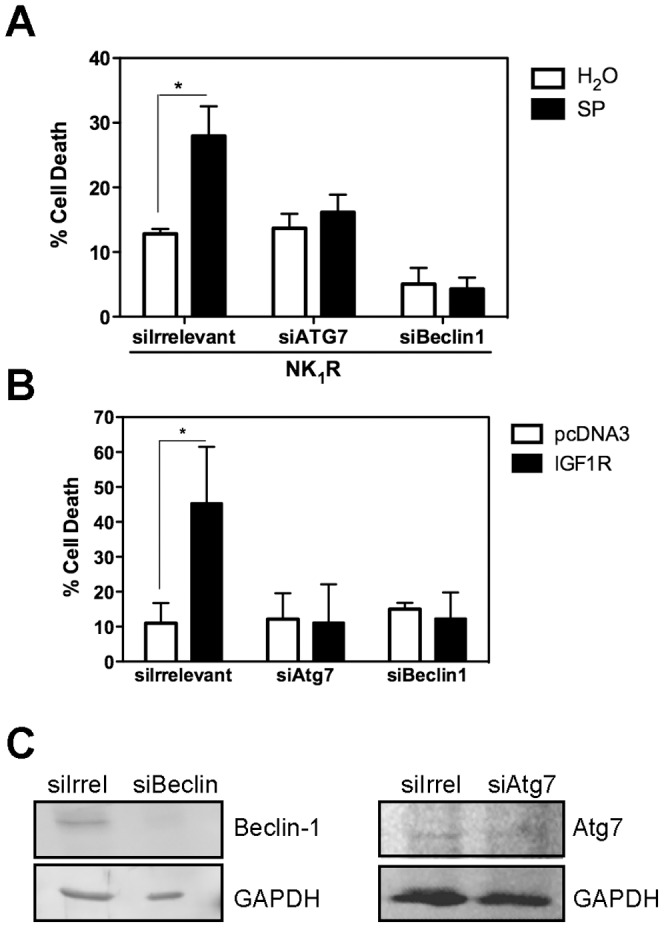
Beclin 1 and Atg7 are necessary for NR4A1-mediated vesicular cell death.
A, HEK293 cells were transfected with NK1R and exposed or not to SP, or B, with the empty vector pcDNA3 or IGF1R. Expression of Beclin 1 or Atg7 was blocked by transfecting SMARTpool siRNAs for them in both models. As control, siRNA targeting a sequence not found in the human genome was transfected. Cells death was determined by trypan blue exclusion 24 hr after cell death induction. Bars represent standard error, (n = 4, * p<0.05). C, Western blot to show the efficiency of the respective RNAi. GAPDH was detected as loading reference. Atg7 signal was particularly low in these cells, therefore the exposure for this blot was longer and the contrast was increased.